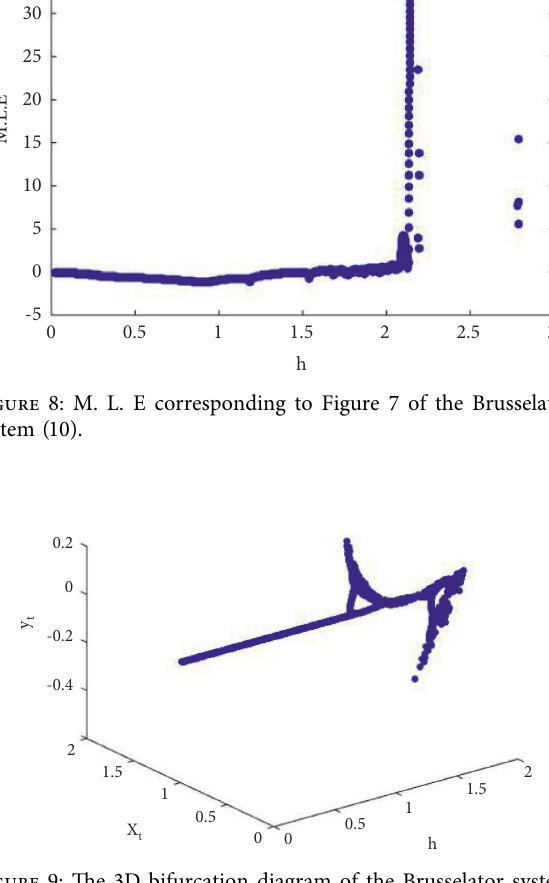
Figure 9: The 3D bifurcation diagram of the Brusselator system (10).